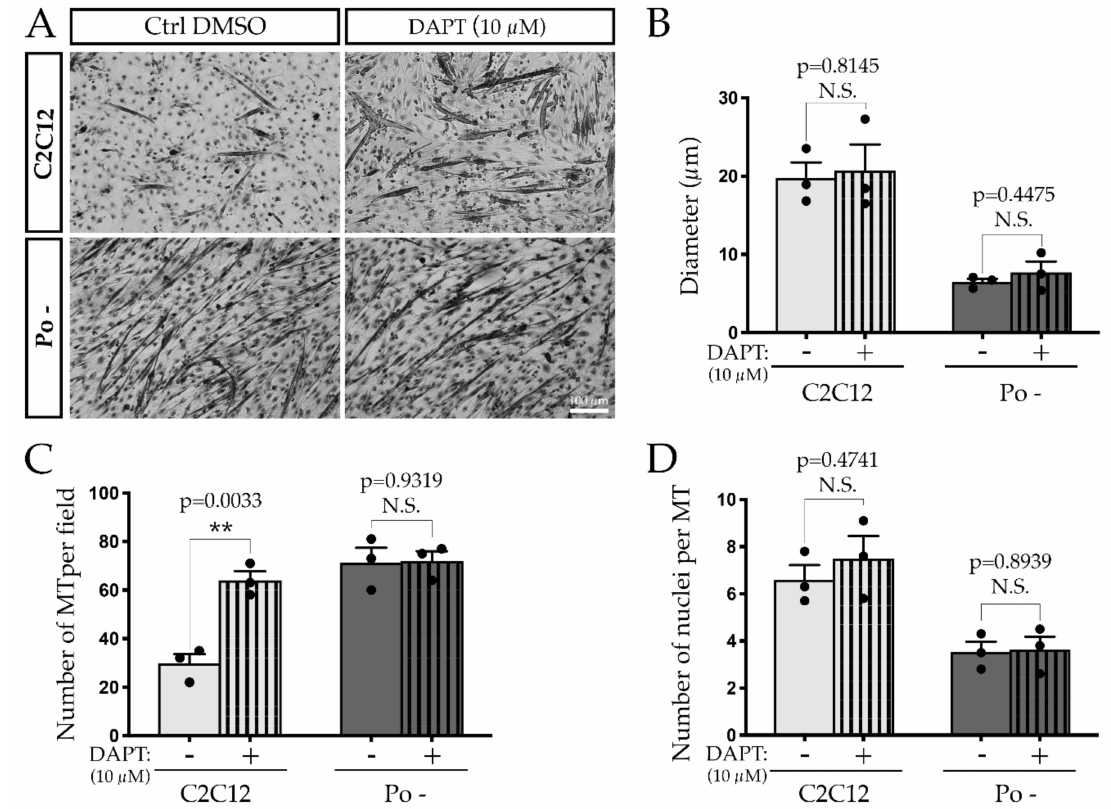
Figure 3. Secondary fusion does not rely on the NOTCH signaling pathway. Photographs show WT C2C12 and Po – cells at 120 h of di ff erentiation treated with DMSO (the control – Ctrl) or DAPT at 10 µ M ( A ). Although the inhibition of NOTCH signaling did not impact the diameter of the MT in any conditions ( B ) the number of MT per field increased in treated WT C2C12 cells and became similar to Po – ones ( C ). The number of nuclei per MT, reflecting the myonuclear accretion, was not modulated following the blockade of NOTCH intracellular domain (NICD) cleavage in both cell lines ( D ). Experiments were conducted in biological triplicates. Bar graphs represented means ± SEM. In B, C and D, each mean of replicates was symbolized by a dark dot. Statistical analyses were performed using a two-tailed Student test, which compared cell lines treated or not with DAPT. **, p < 0.01. N.S., not